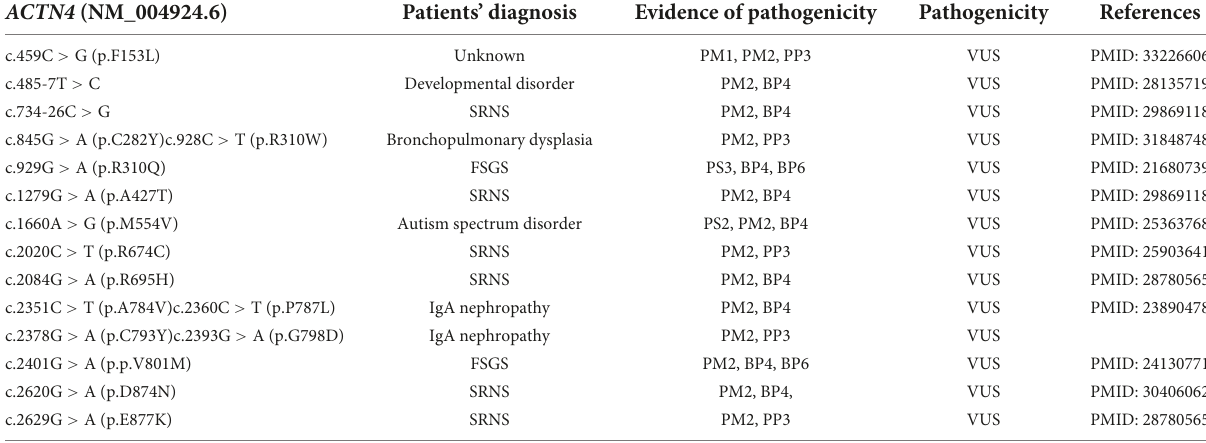
TABLE 2 The known variants of VUS in the ACTN4